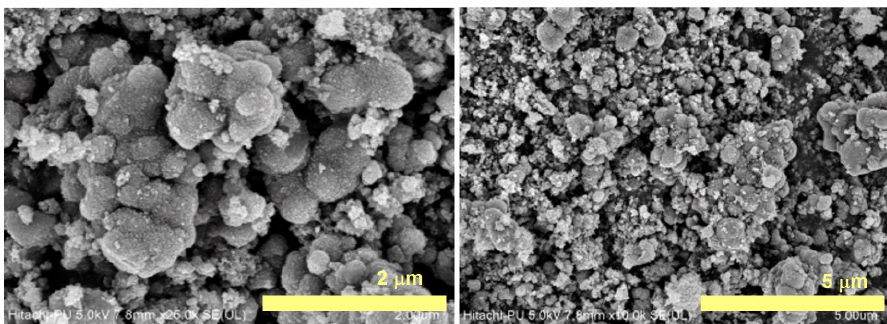
Figure 14. FE SEM images of functionalized organic-inorganic nano composite (12) .